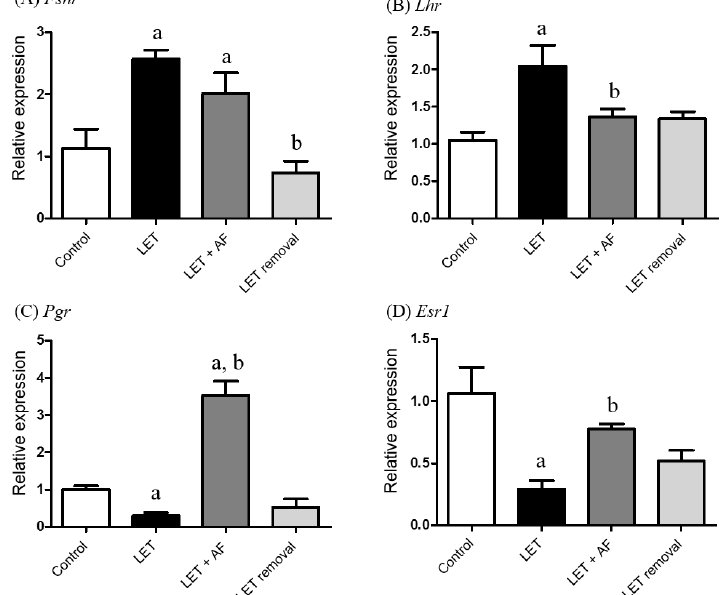
Figure 5. Effect of A. fistulosum root extract on ovarian gene expression related to hormone receptors in letrozole-induced PCOS rats. Comparison of mRNA expression levels of ( A ) Fshr, ( B ) Lhr, ( C ) Pgr, and ( D ) Esr1 from ovaries of each experimental group as assessed by quantitative RT-PCR.; Rplp0 was used as in internal control. Values represent means ± SEM; n = 5–10 per group; a p < 0.05 vs. Control group b p < 0.05 vs. LET group. AF; A. fistulosum ; Esr1: estrogen receptor 1; Fshr : follicle-stimulating hormone receptor; LET; letrozole; Lhr: luteinizing hormone receptor; Pgr: progesterone receptor.